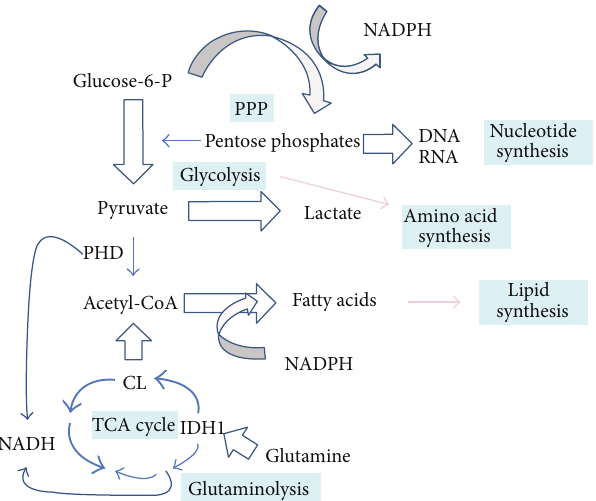
Figure 1: A simplified scheme of metabolic pathways in cancer cells (modified from Heiden et al. [51] and Denkert et al. [11]). Thickness of arrows indicates relative intensity of fluxes. PDH: pyruvate dehy- drogenase; CL: citrate lyase; IDH1: isocitrate dehydrogenase 1.